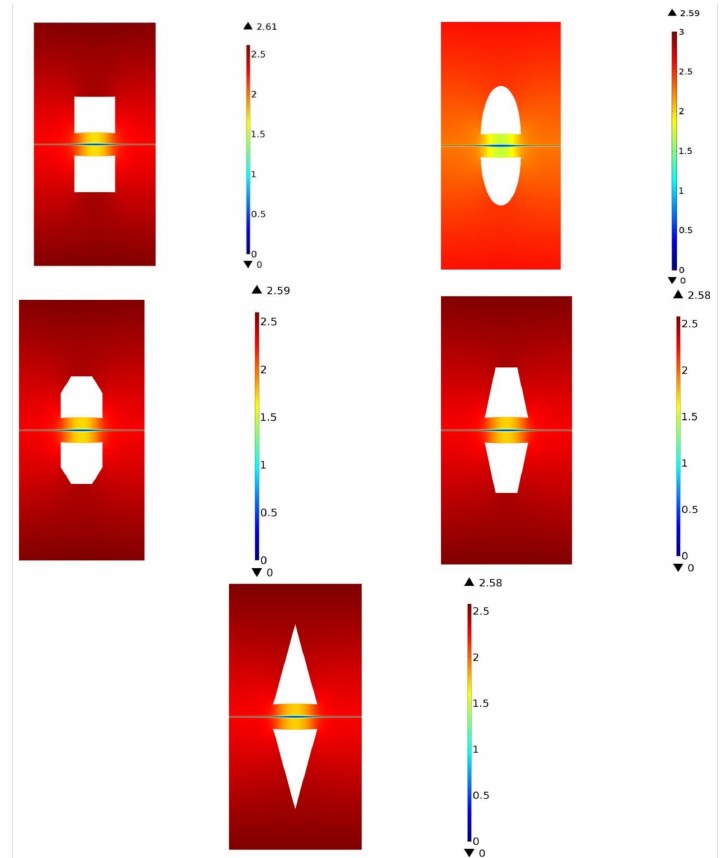
Figure 10. The displacement ( µ m) in the PEM-FC through the process of assembly at the 1 mm 2 cross-section area, with scale increased 50